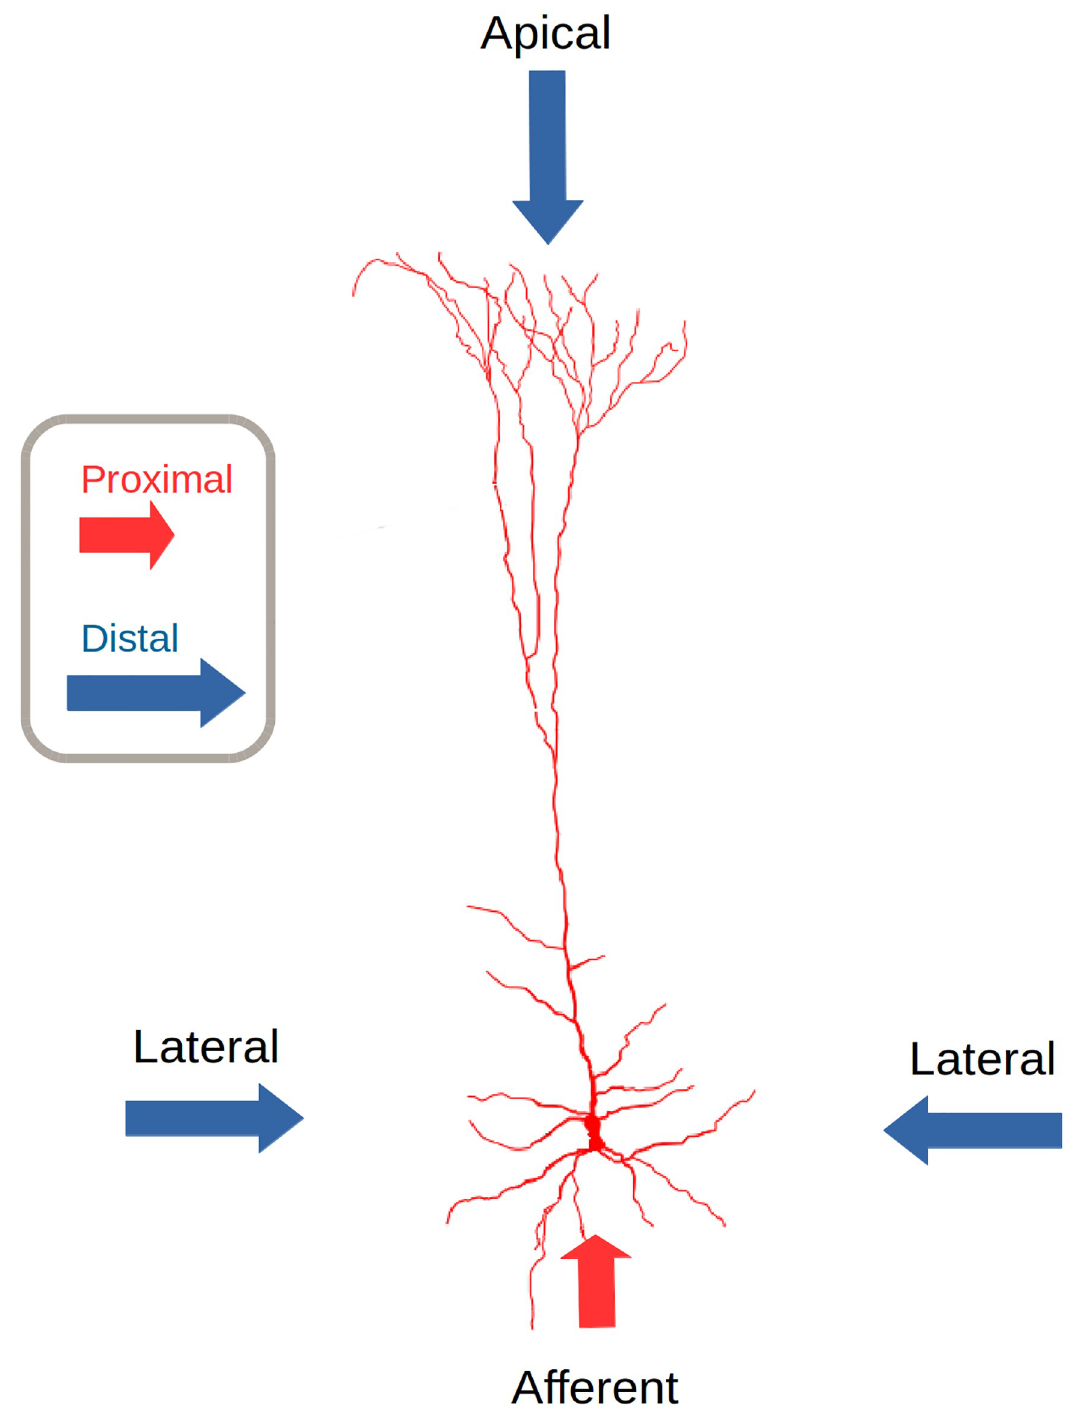
Fig 2. Connectivity profile of a pyramidal neural unit in the Encoder Layer (EL). Proximal connections are formed only by afferent connections from the Multiresolution Spectro-Temporal Sound Analysis (MRSTSA) while distal connections are formed by lateral and apical connections from neighboring columns and from columns in another cortical layer above respectively. The EL is the most important stage in our computational approach while the MRSTSA pre-processes the audio corpora in order to feed the EL. Adapted from (Fabuio—Own work, CC BY 4.0, https://commons.wikimedia.org/w/index.php?curid=60707501).